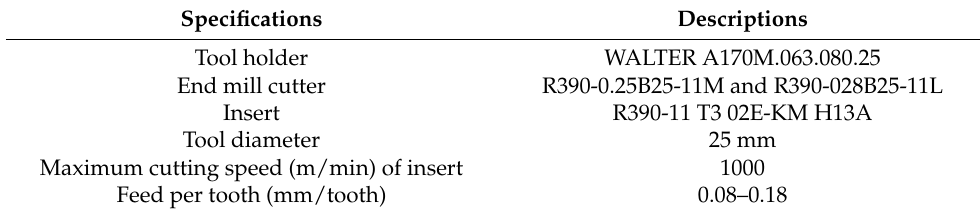
Table 4. Tool holder, end miller cutter, and insert